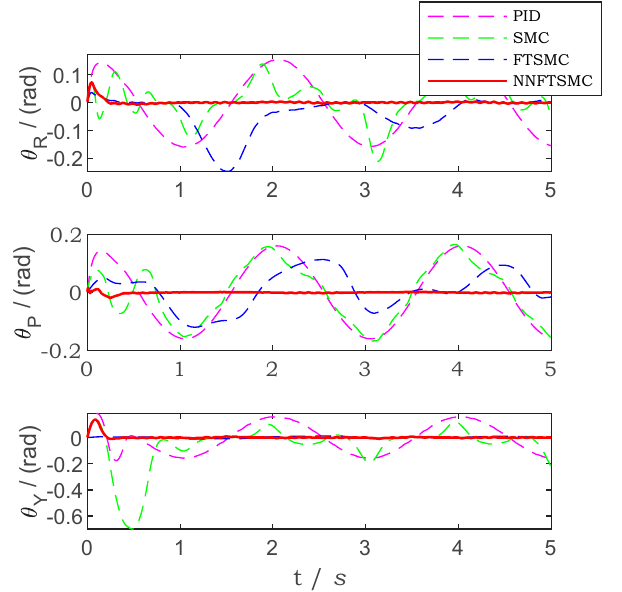
Figure 8. The trajectory tracking error by using different controllers in the simulation of sine trajectory.